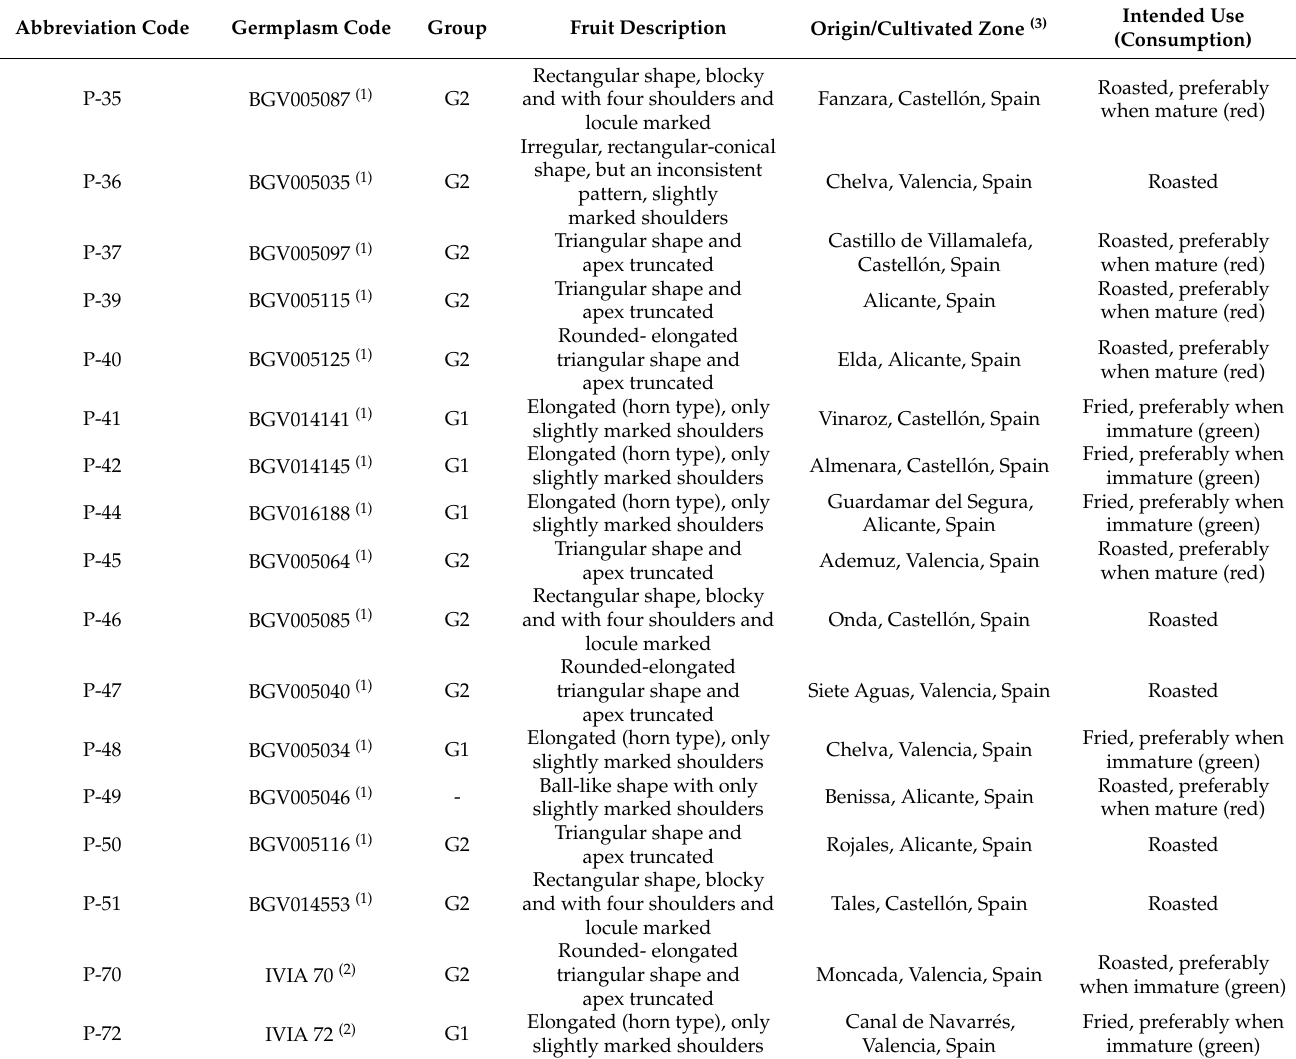
Table 1. Abbreviation, germplasm collection code, group (based mainly on fruit characteristics obtained in the actual study, G1 = elongated; G2 = triangular, square or blocky; “-” = non-grouped), fruit shape description, and origin of the 17 varieties of pepper used in the study. Plant material was provided by: (1) the Valencian Institute for the Conservation and Improvement of Agrobiodiversity (COMAV, Spain) and (2) the Valencian Institute for Agricultural Research (IVIA, Spain). (3) Town, province,